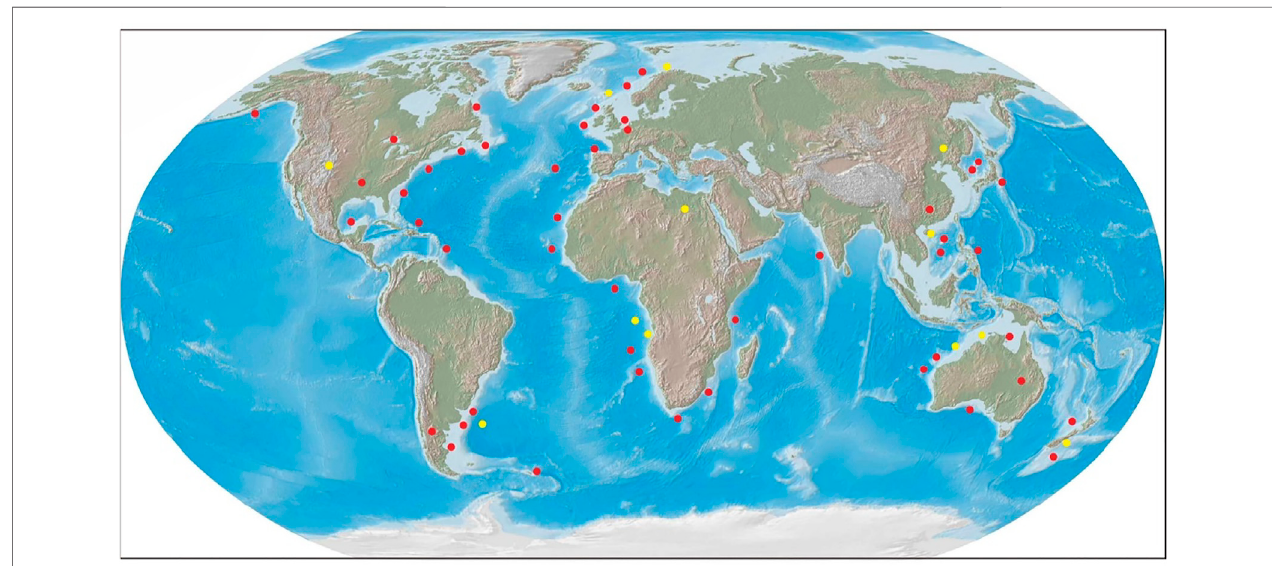
FIGURE 1 | Global distribution of the polygonal faults discovered all over the world (modi fi ed after Cartwright, 2011). In this study PF occurrences discovered after 2010 (yellow dots) are added which is a supplement of previous compilation (red dots; Cartwright, 2011).